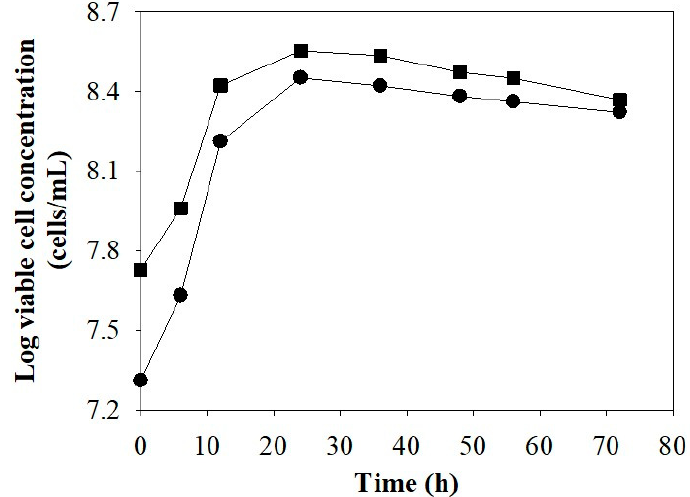
Figure 6. Viable S. cerevisiae NP01 cells during ethanol production from the sweet sorghum juice supplemented with yeast extract (3 g / L), DSY (4 g / L), and glycine (5 g / L) with ( (cid:4) ) and without ( (cid:8) ) aeration. Table 5. Fermentation parameters of ethanol production from the sweet sorghum juice under optimal nutrient conditions ( A 2 B 1 C 3 ) with and without aeration.